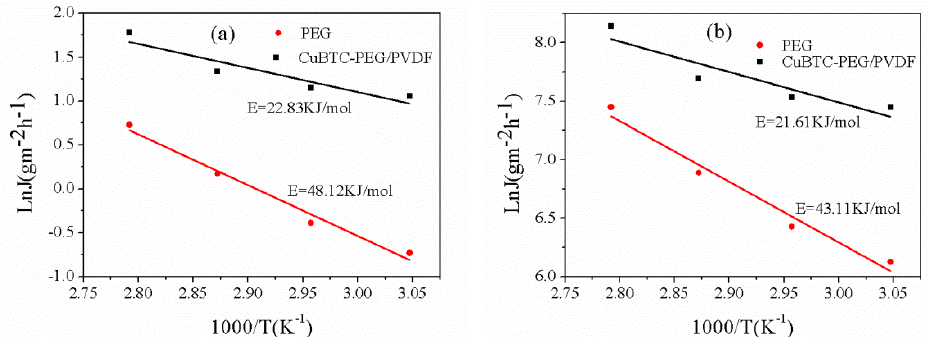
Figure 9. Arrhenius plots of the PEG and CuBTC-filled PEG MMMs for thiophene ( a ) and n -heptane ( b ).